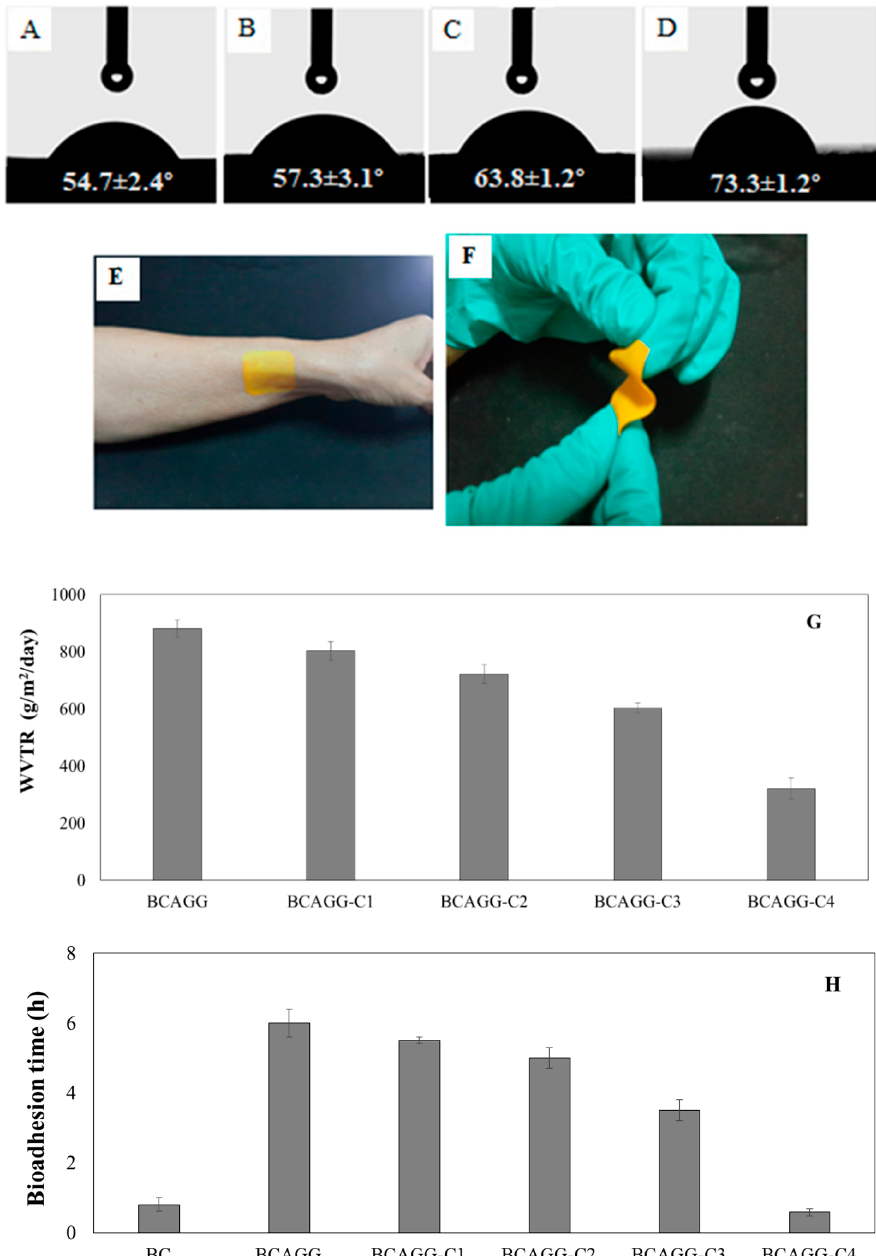
Figure 4. Water contact angles of: ( A) BCAGG-C1; ( B ) BCAGG-C2; ( C ) BCAGG-C3; and ( D ) BCAGG-C4; ( E ) film attachment to skin; ( F ) film flexibility; ( G ) WVTR; and ( H ) bioadhesion time.